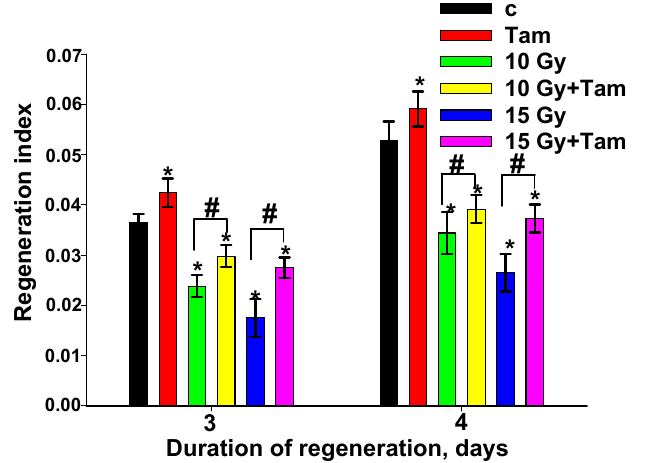
Figure 1. Radioprotective effects of Tameron on regenerating planarians in non-irradiated animals and after X-ray irradiation with 10 and 15 Gy. c—non-irradiated control, Tam—Tameron (10 − 4 M). * p < 0.001 (difference from control), # p < 0.001 (difference from irradiated group without Tameron treatment). Data are presented as mean ± SD.